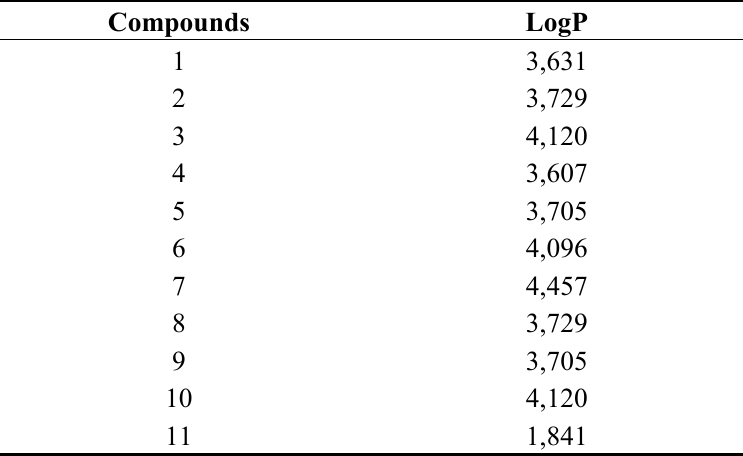
Table 2. LogP (octanol/water partition coefficient) values calculated for the amino/nitro substituted 3-arylcoumarins 1 – 11 a